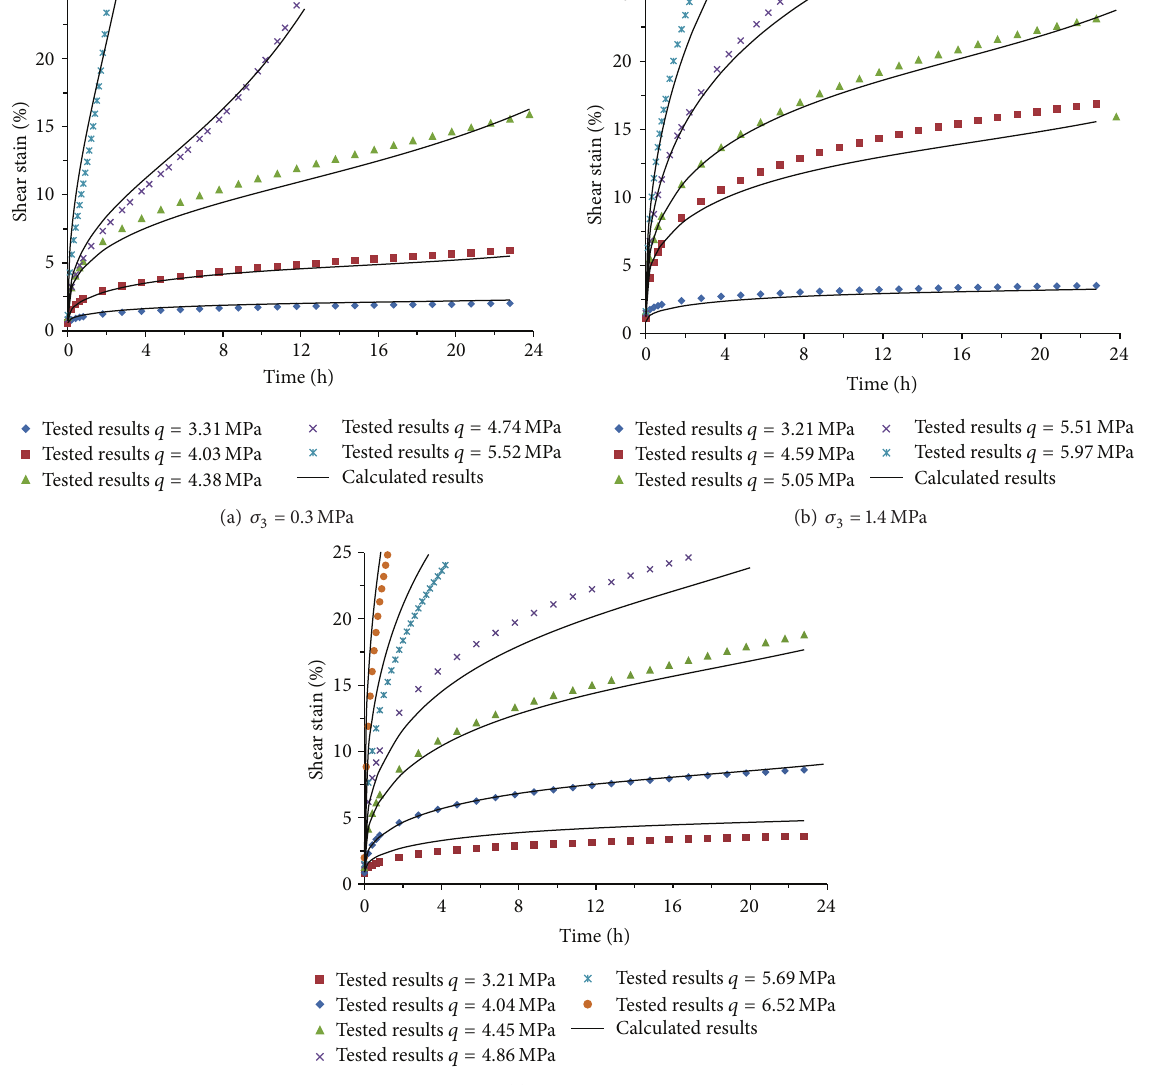
Figure 9: Comparison between tested results and calculated